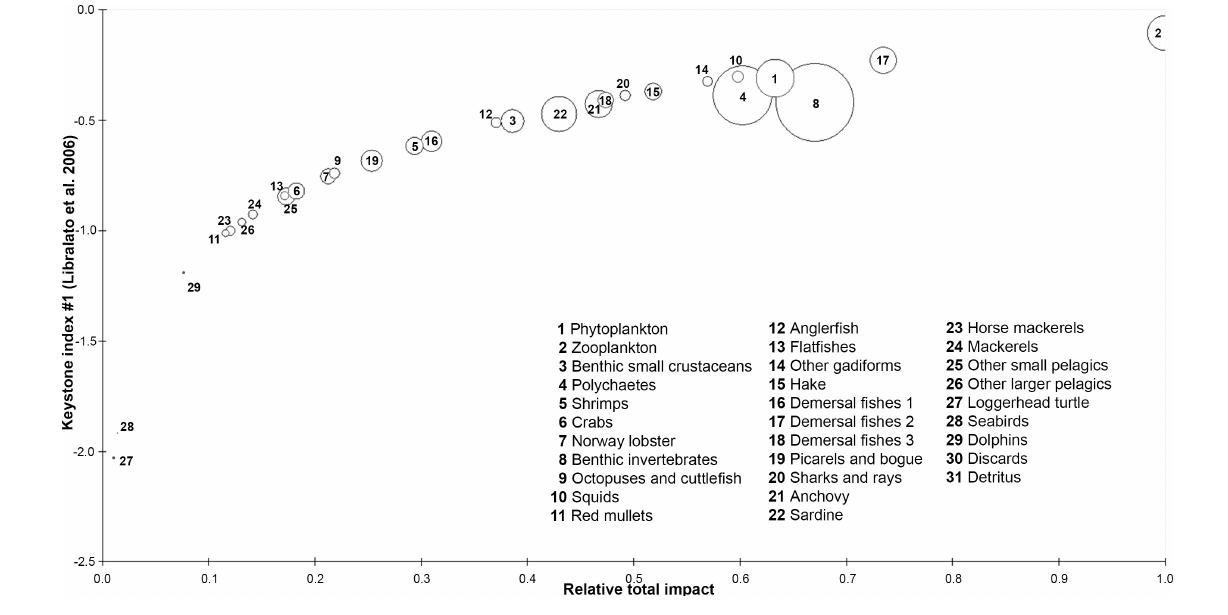
biomass in the end of the simulation period, by 21 and